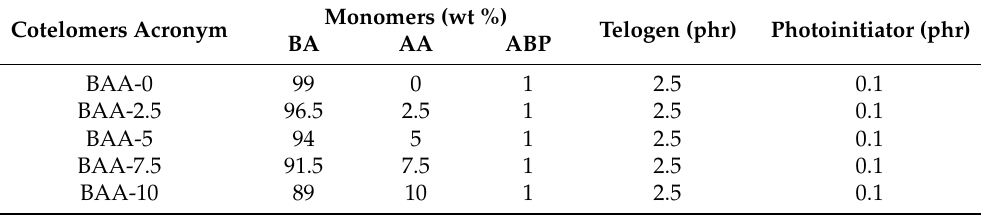
Table 1. Compositions of regents for the UV-induced cotelomerization process. Cotelomers